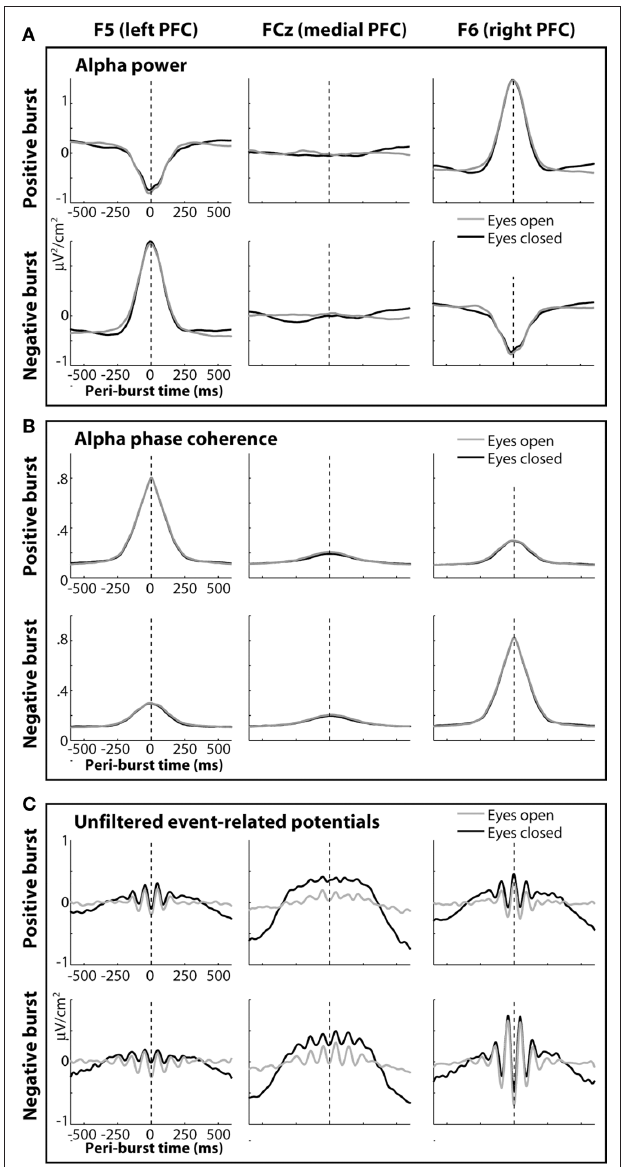
FIGuRE 12 | The temporal dynamics of power and inter-burst phase coherence for left (F5) medial (FCz) and right (F6) loci. Bursts were defined based on the power difference ln(F6) − ln(F5), with positive bursts representing extreme positive values on this metric, and negative bursts representing extreme negative values on this metric. (A) displays peri-burst alpha power; (B) displays inter-burst phase coherence; (C) displays event-related potentials, created by time-locking unfiltered EEG to each